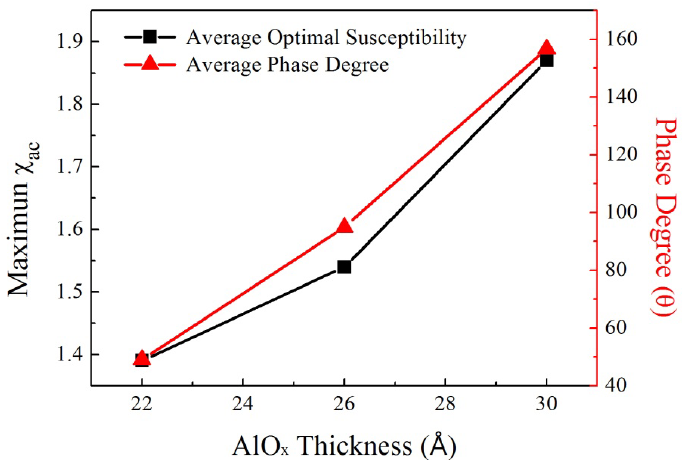
Figure 5. Mean optimal susceptibility and average phase angle as functions of AlO barrier thickness.